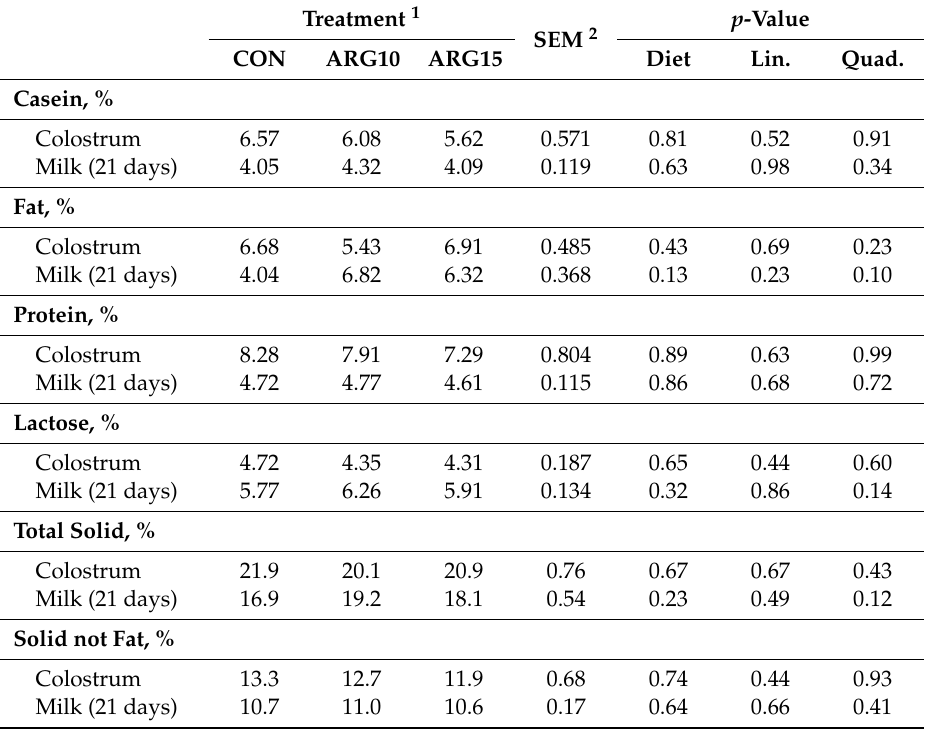
Table 8. E ff ects of arginine supplementation levels during late gestation on milk composition in lactating sows.